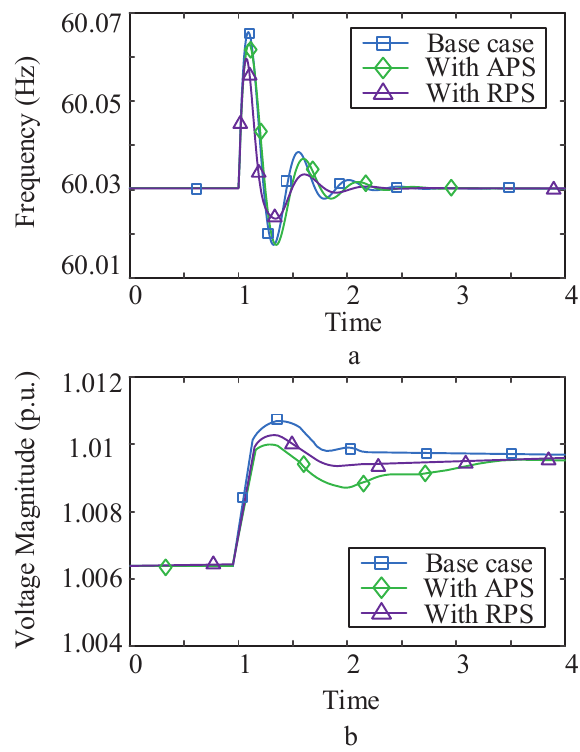
Figure 10. Synchronous DG response to 10% load shedding; ( a ) Frequency ( b ) Voltage